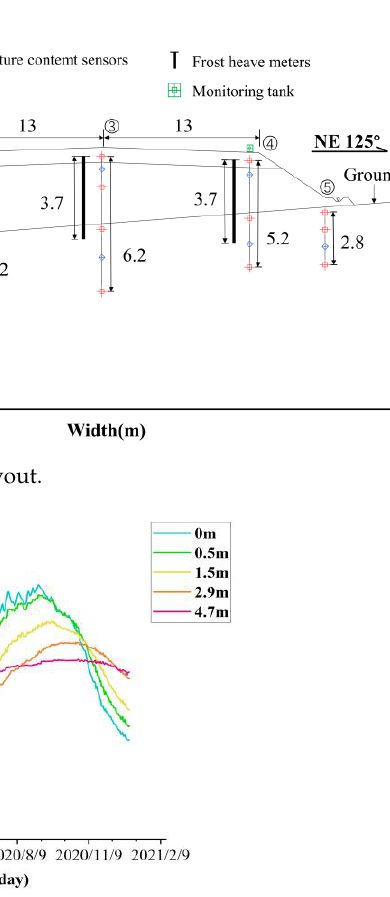
Figure 3. K3588 + 100 section right shoulder temperature monitoring